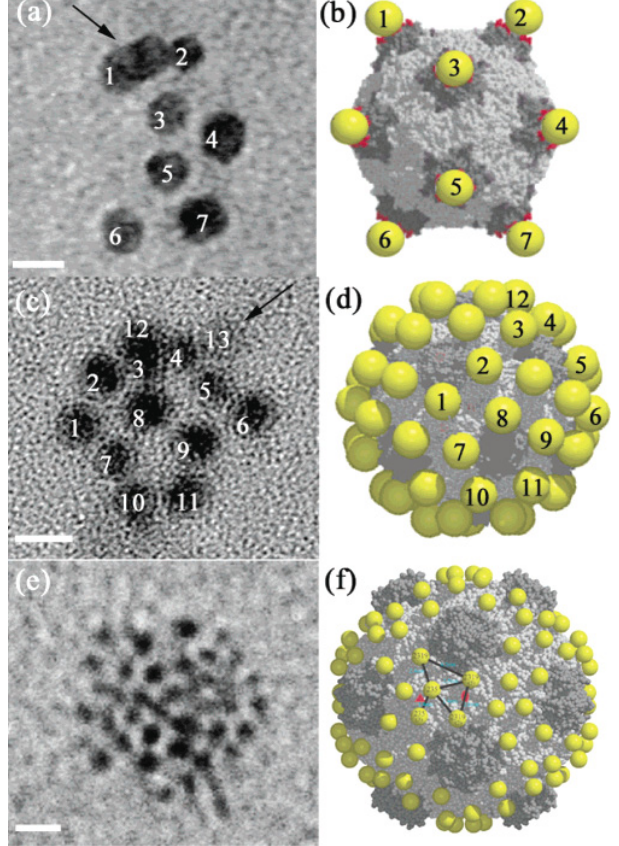
Figure 6. Cowpea Mosaic Virus (CPMV) can be modified to bind GNPs. ( a ), ( c ), and ( e ) show unstained TEM images of GNPs bound to different cysteine mutants of CPMV with GNPs visible as black circles. Scale bars are 5 nm; ( b ), ( d ), and ( f) show models of CPMV with GNPs bound to modified sites. Reprinted with permission from Ref. [66]. Copyright 2004 American Chemical